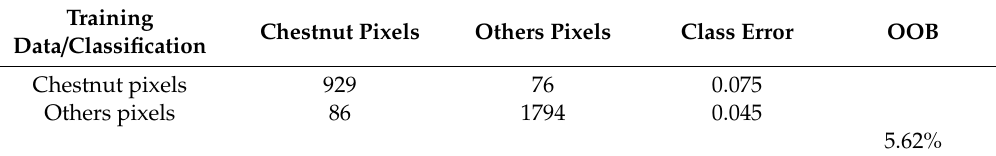
Table 4. Training data classification results for Model 2, including the out-of-bag (OOB) error. Model created using RF. Predictive variables, variables selected by the selection algorithm (VSURF).